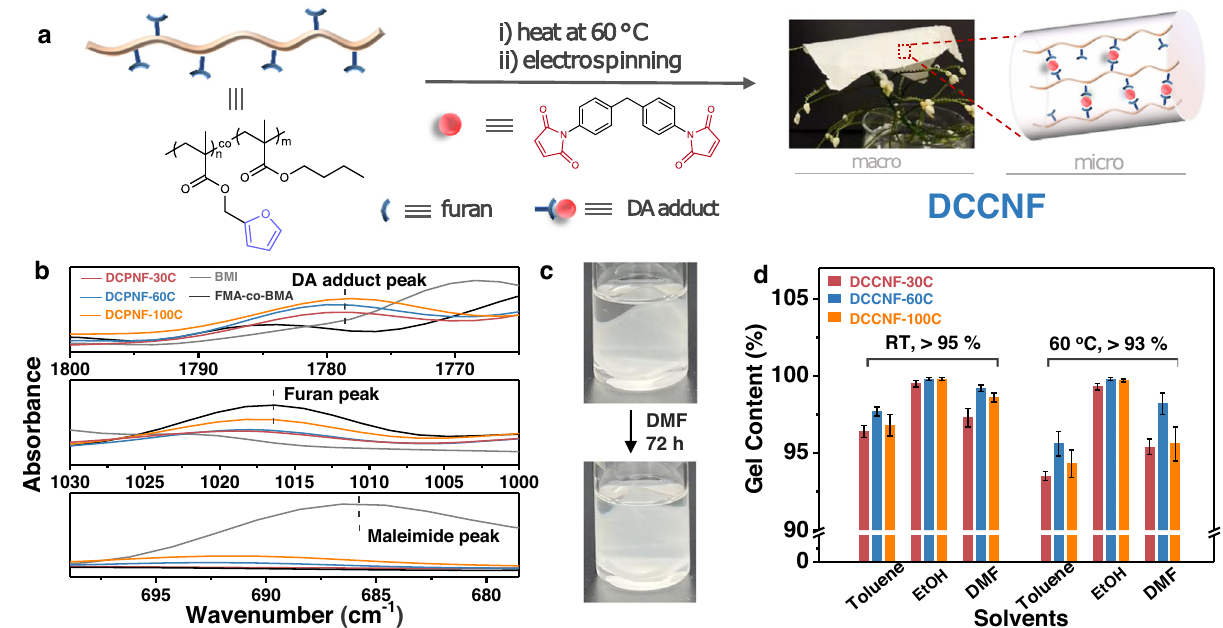
Fig. 2 | Fabrication of DCCNFs. a Fabrication route of DCCNFs and the schematic diagram of their crosslinking network; b FTIR spectra of FMA-co-BMA, BMI and DCCNFsinselectedwavenumberrange; c DigitalphotosofDCCNF-60Cbeforeand